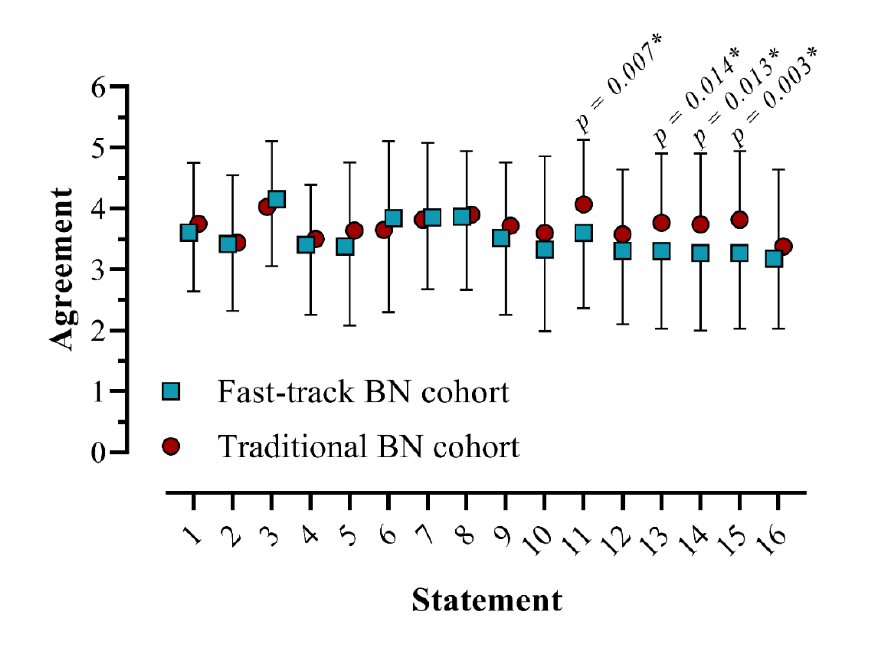
Agreement Scores in Response to each Survey Statement for both Student